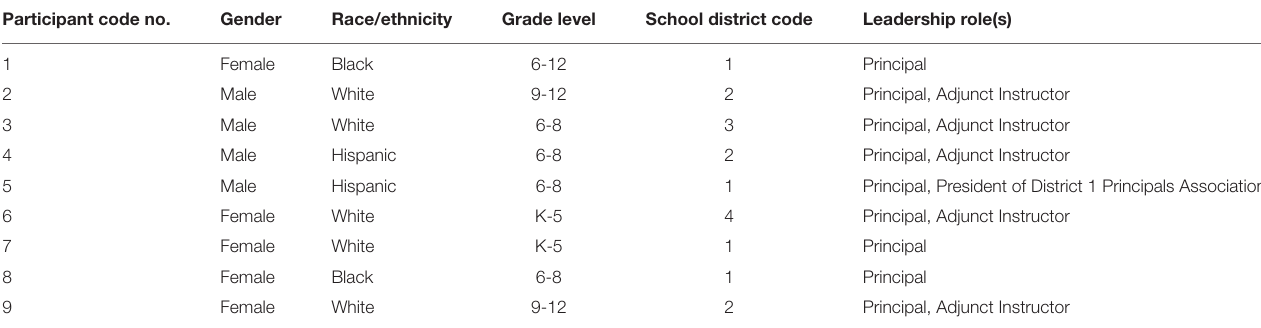
TABLE 1 | Demographic information of participating principals. Participant code